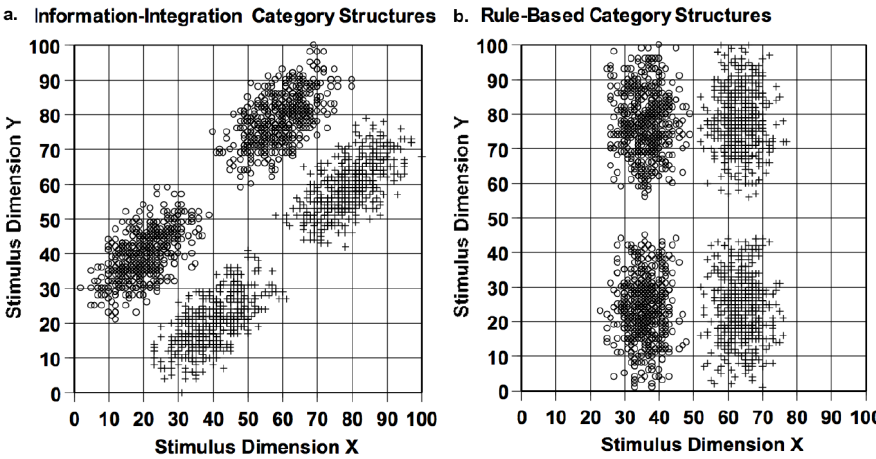
Figure 16. ( a ) A training-generalization information-integration category structure, depicted in the same way as Figure 12. The bottom pair and top pair of stimulus ellipses, respectively, were the defined categories during training and generalization; and ( b ) a training-generalization rule-based category structure, depicted in the same way.